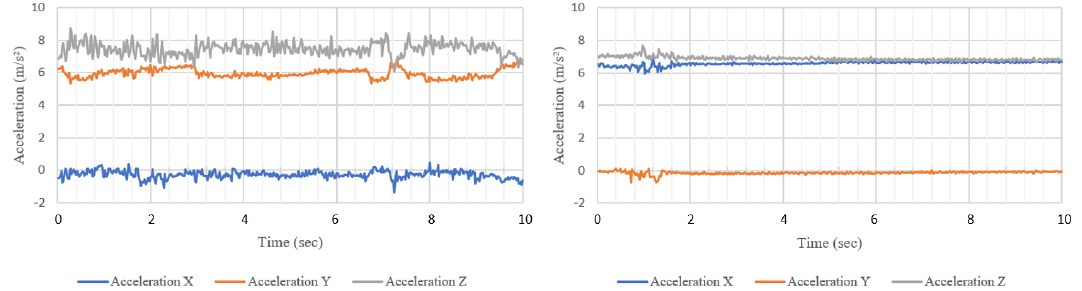
Figure 1. Ten seconds of acceleration data for a. typing (left) and b. watching (right), both while seated. The acceleration data for typing shows greater variation while the data for watching is